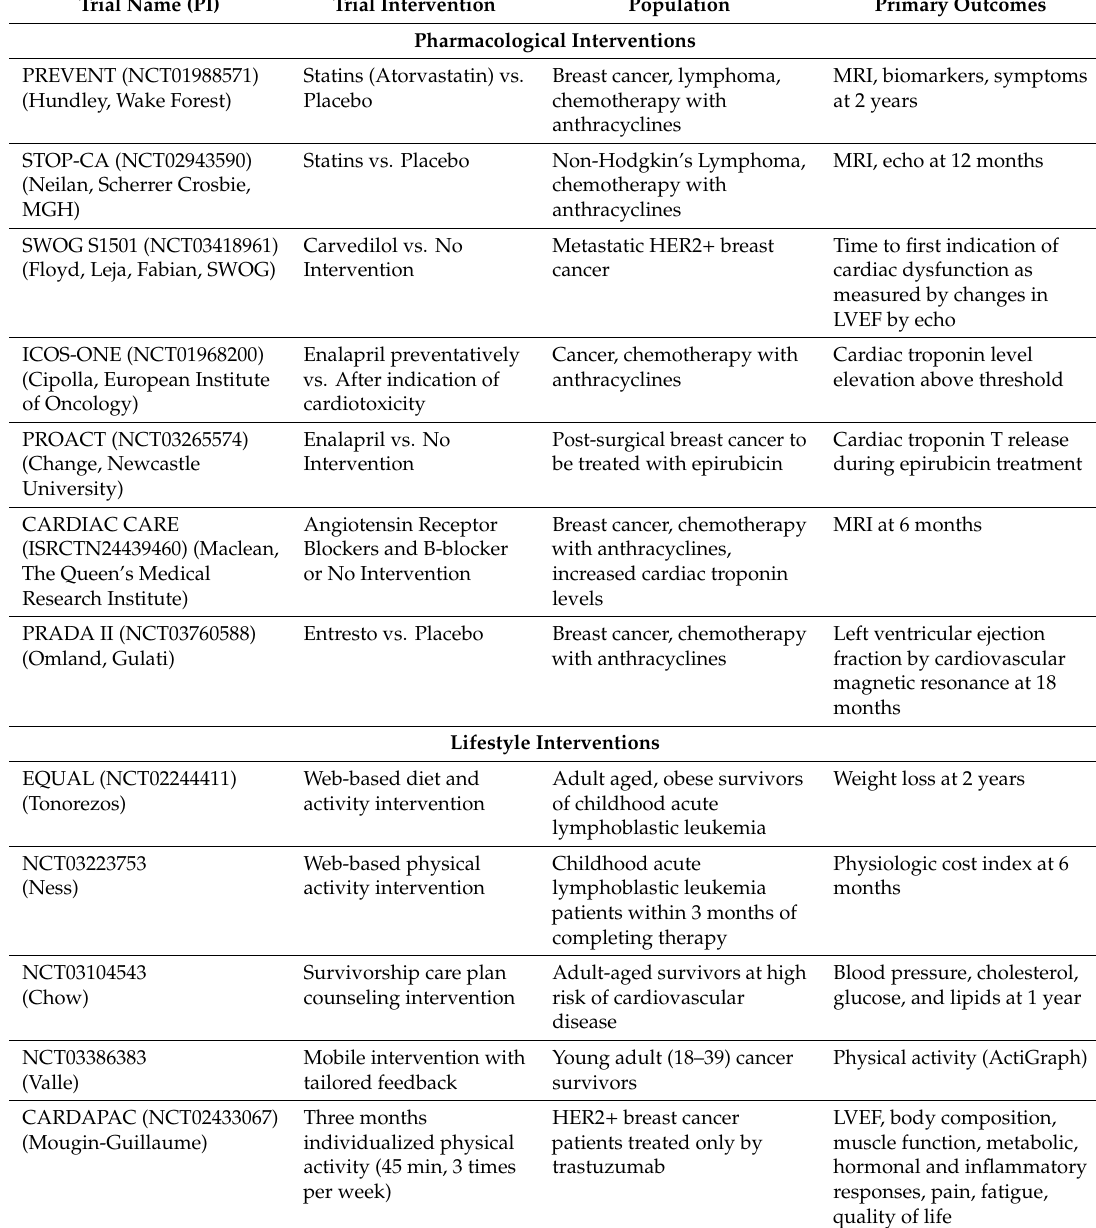
Table 2. Ongoing pharmacological and lifestyle cardioprotection